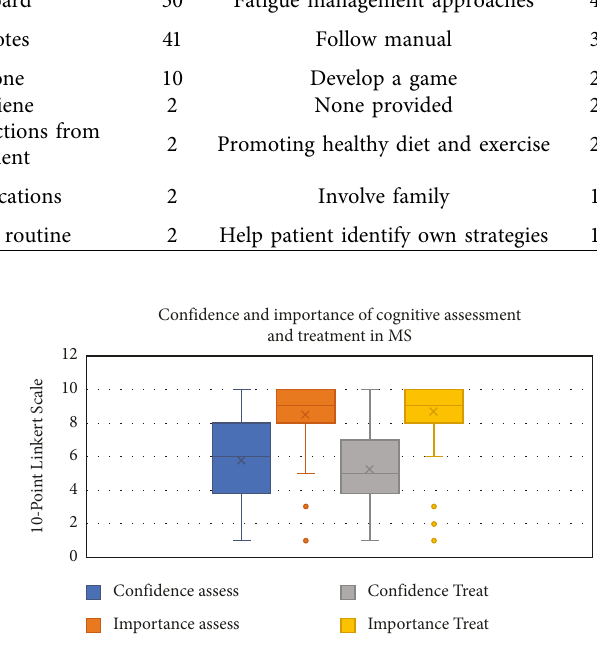
Figure 4: Healthcare professional’s rating of importance and confidence in cognitive